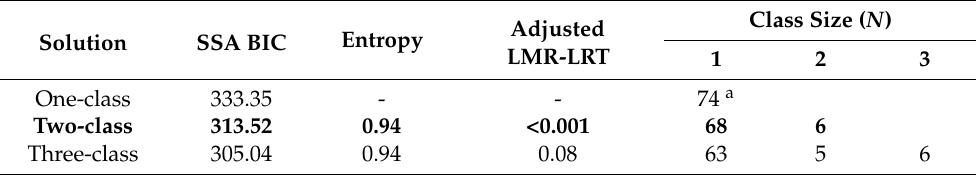
Table 3. Model Fit Indices for All Growth Mixture Models for